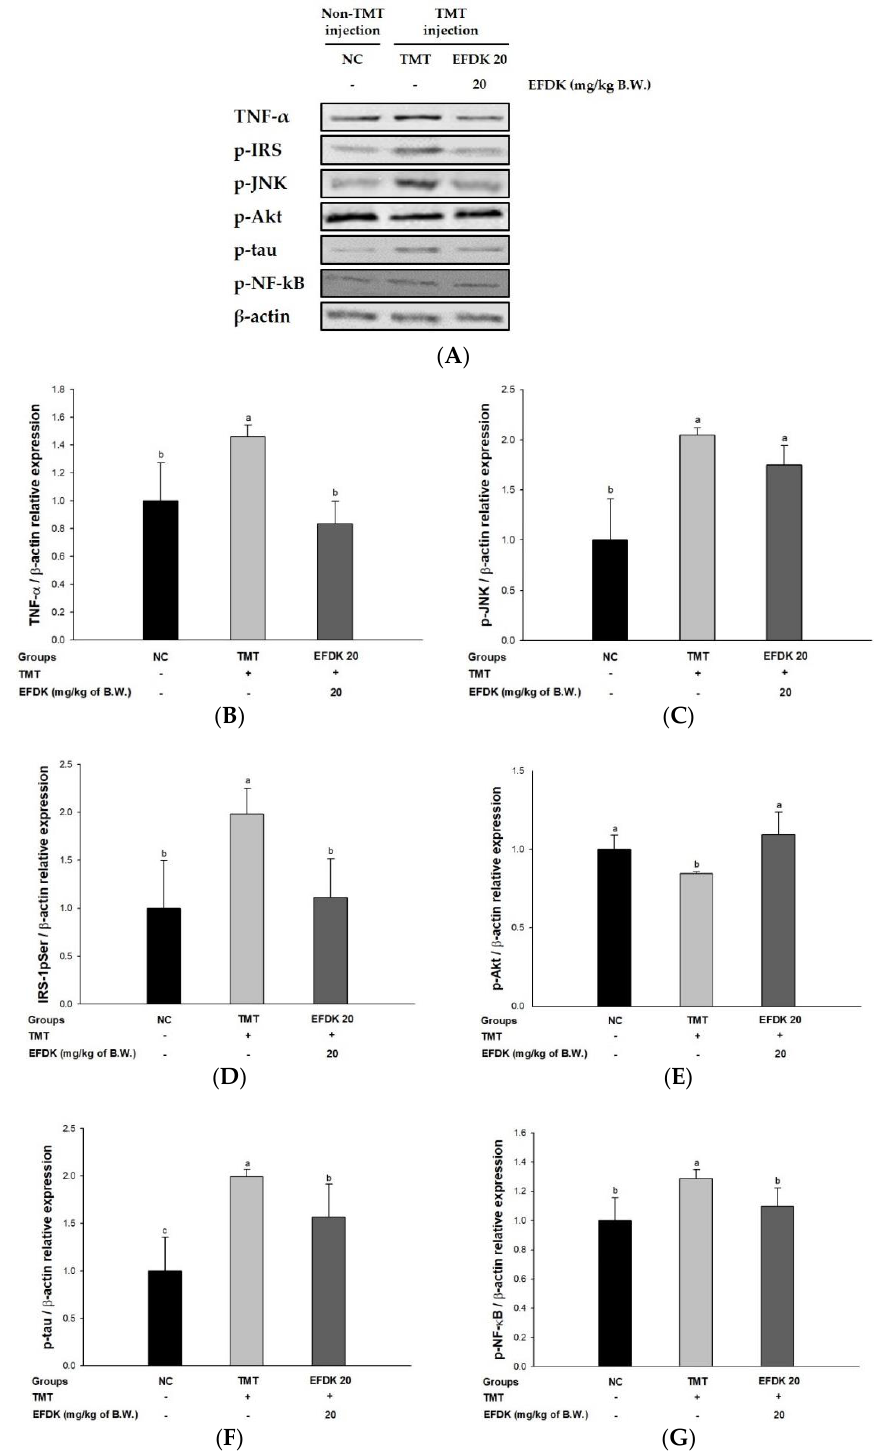
Figure 8. Protective effect of ethyl acetate fraction from persimmon (EFDK) on JNK/Akt pathway in mice brain tissues. ( A ) Representative western blots for total protein and expression of TNF-α, p-JNK, IRS-1pSer, p-Akt, p-tau, p-NF-κB and β-actin; Protein expression levels of TNF-α ( B ); p-JNK ( C ); IRS-1pSer ( D ); p-Akt ( E ); p-tau ( F ) and p-NF-κB ( G ) normalized to β-actin. Results shown are mean ± SD ( n = 3). Data were statistically represented at p < 0.05, and different small alphabets mean statistical significance.